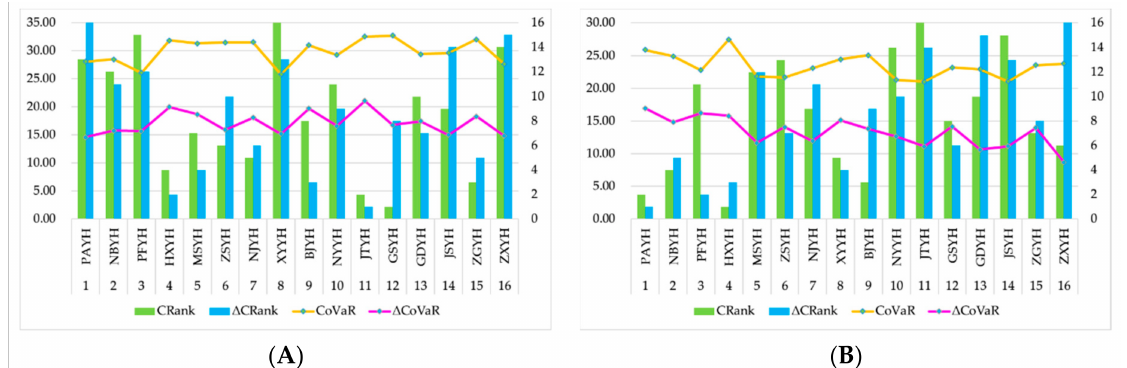
Figure 3. The results of CoVaR and ∆ CoVaR (In the figure, the CoVaR refers to the Conditional Value at Risk when a bank is in distress; ∆ CoVaR refers to the di ff erence between the CoVaRs when the bank is in distress and in a normal state): ( A ) 2013; ( B )